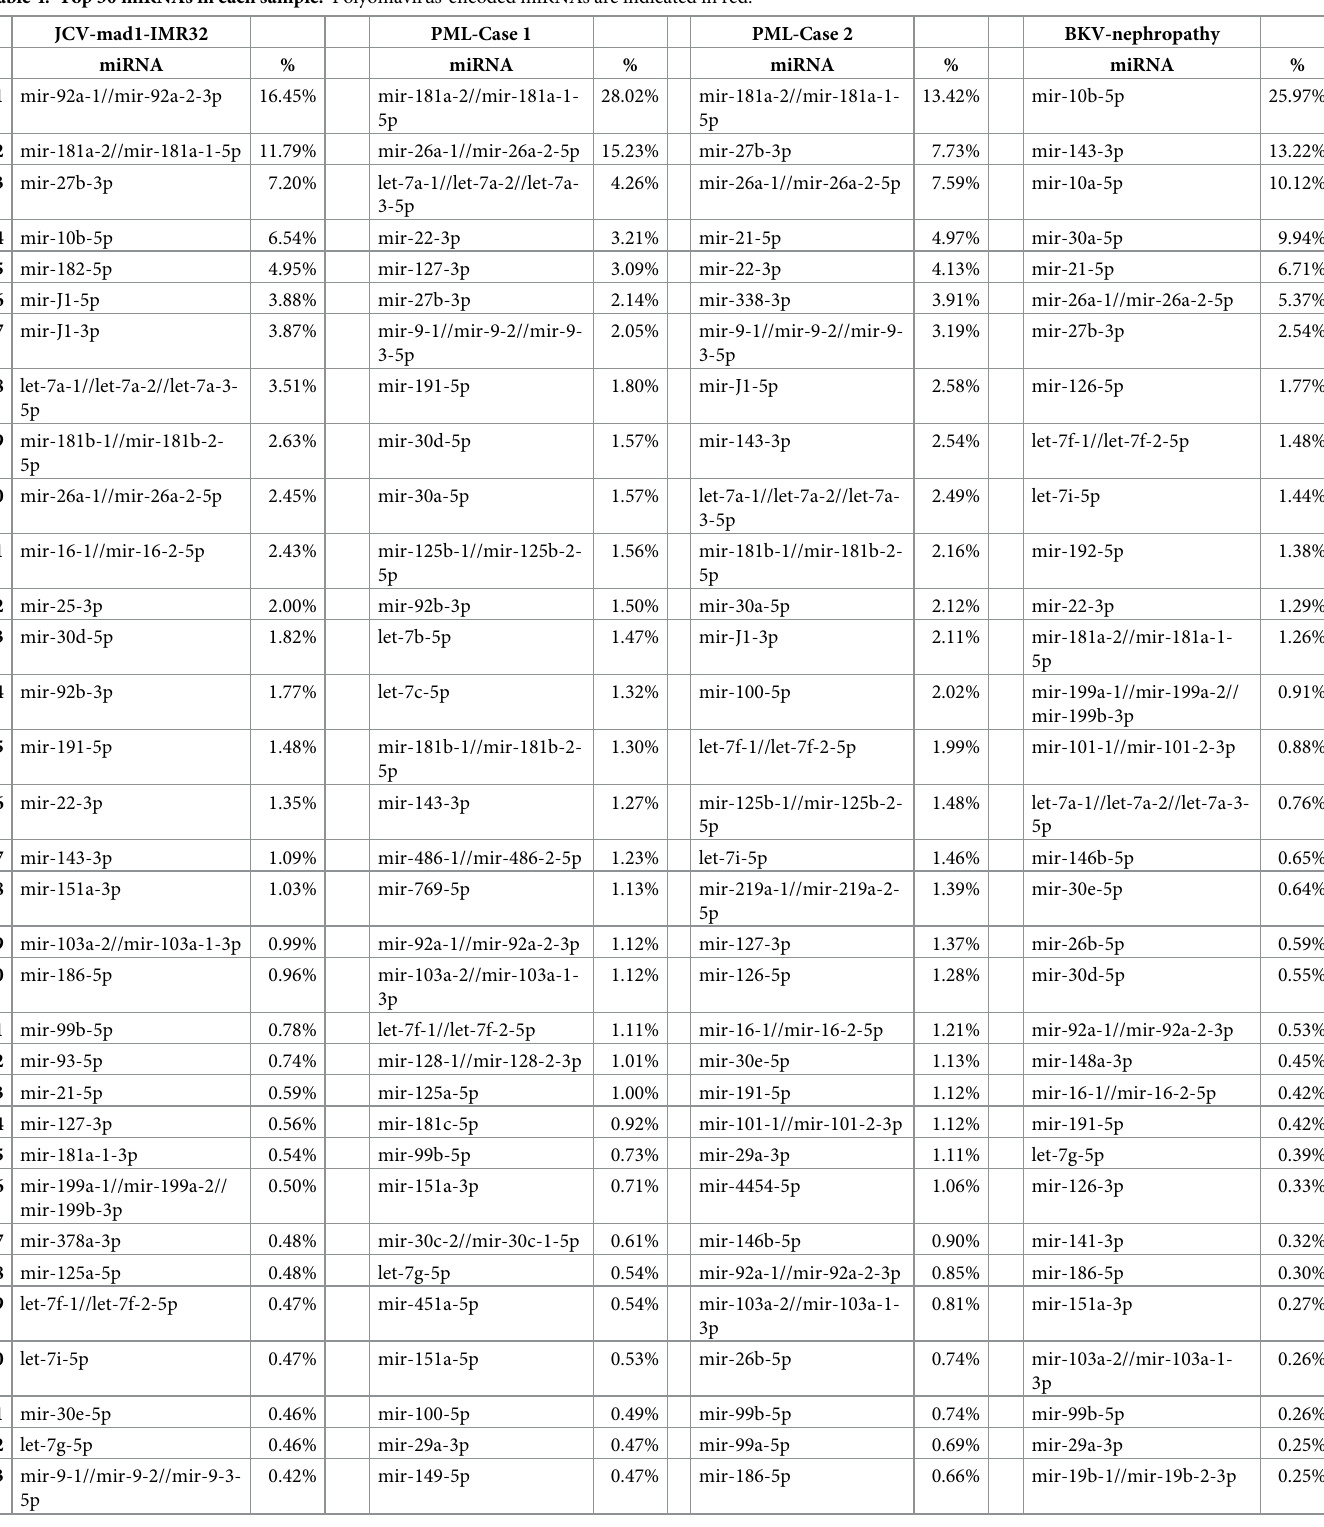
Table 4. Top 50 miRNAs in each sample. Polyomavirus-encoded miRNAs are indicated in red.